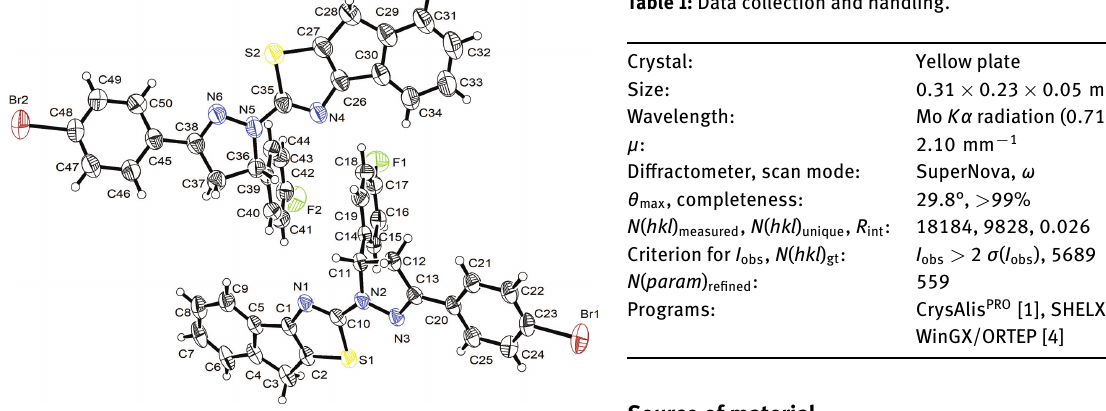
Table 1: Data collection and